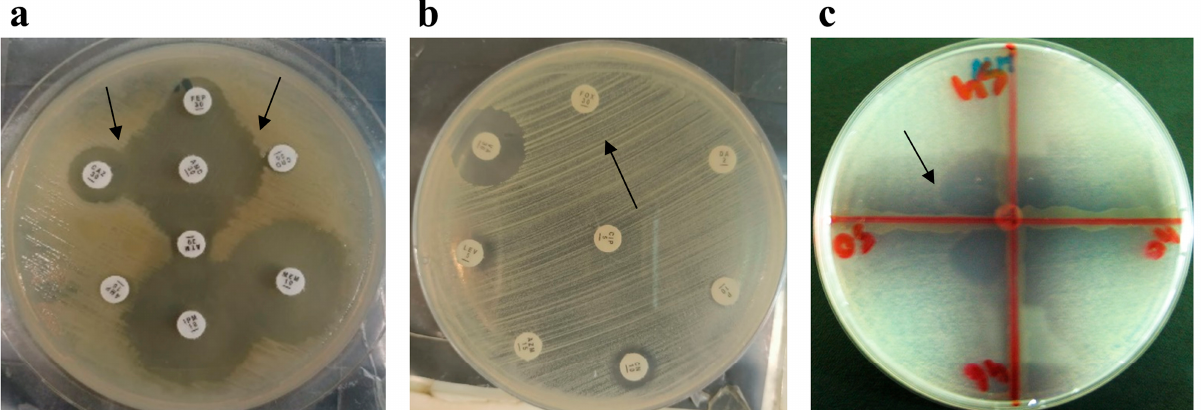
Figure 2. Phenotypic detection of antimicrobial resistance genes in isolates recovered from food samples. ( a ) Extended-spectrum β -lactamase-producing E. coli ; the black arrows indicate the synergistic effect of antibiotics. ( b ) Methicillin-resistant Staphylococcus aureus ; the black arrow indicates cefoxitin resistance. ( c ) Carbapenemase-producing E. coli ; the black arrow indicates the extension of growth towards the meropenem disc.